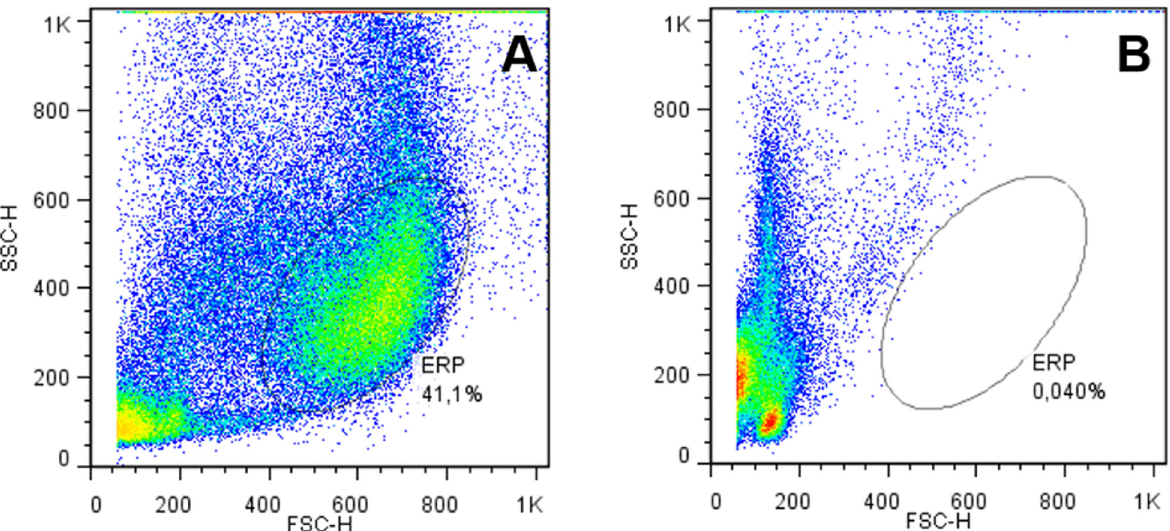
Fig 2. Erythrocytes-rich population (ERP) of O . niloticus . (A) Normal blood and (B) after erythrocytes lysis using SSC (side scatter) X FSC (forward scatter) parameters.